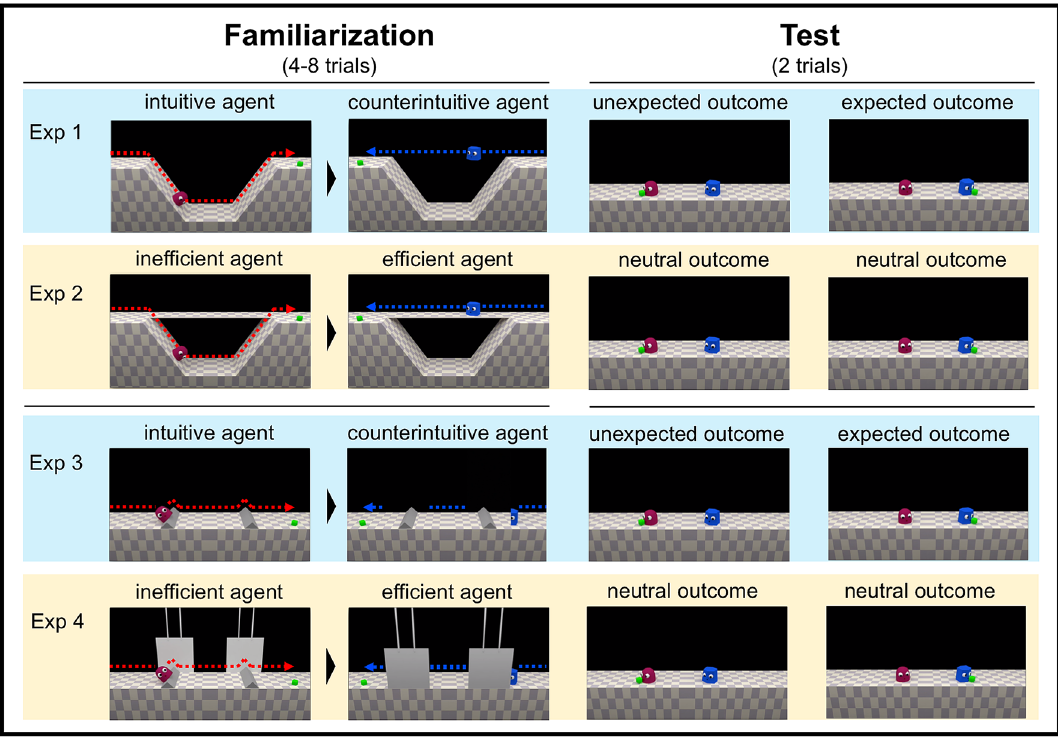
Figure 1. The procedure of the experiments. In the familiarization phase of Exp 1 and 3, a pair of agents gain a reward using either a physically intuitive or physically counterintuitive method. The latter was more efficient because the agents move in a straight line, which was the shortest distance to the reward (Exp 1), or disappear before each bump and quickly reappear after it, which leads faster goal-achievement (Exp 3). In Exp 2 and 4, both agents obtained the reward by moving in trajectories and speed identical to Exp 1 and 3 using physically intuitive methods (Exp 2, 4). Dotted lines present the trajectory displays of the agents (the lines do not exist in the videos), which are the same between Exp 1 and 2, and between Exp 3 and 4. In the test phase, either of the agent from the same pair of familiarization phase gains a zero-sum